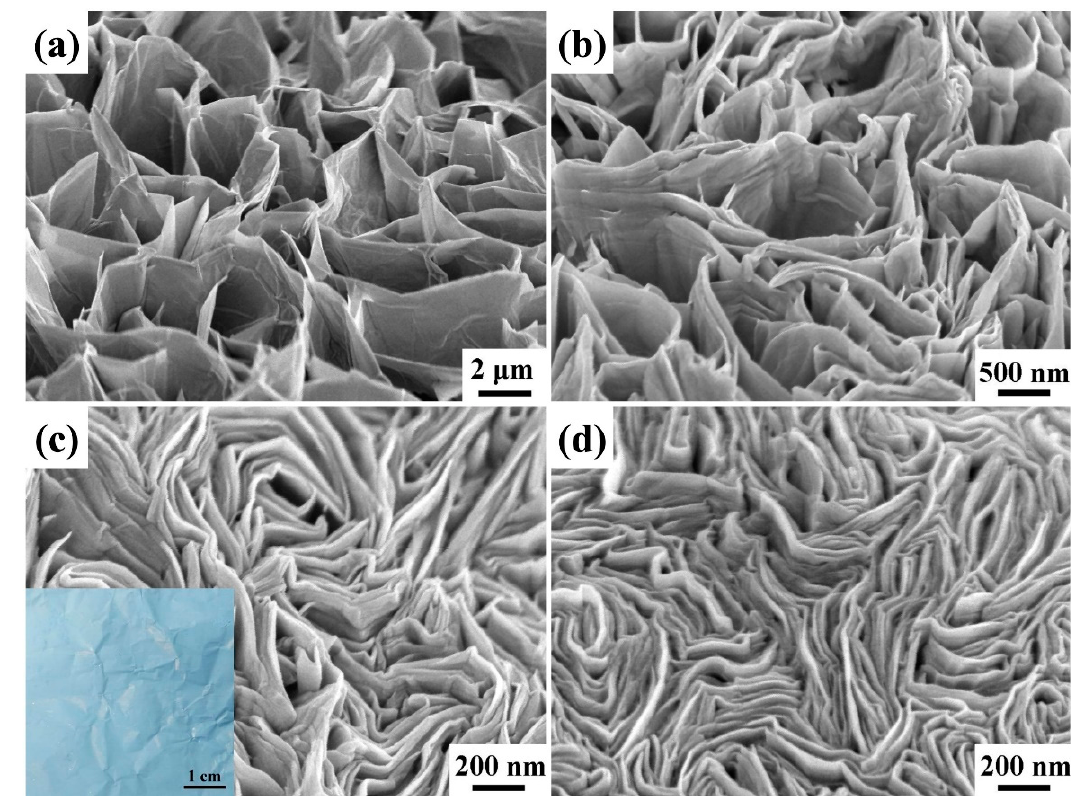
Figure 4. The tilt-view FESEM images of ZnO nanowalls grown on the Al foil at different concen- trations of ZnO precursors. The concentrations of ZnO precursors are ( a ) 10, ( b ) 25, ( c ) 50, and ( d ) 75 mM, respectively.